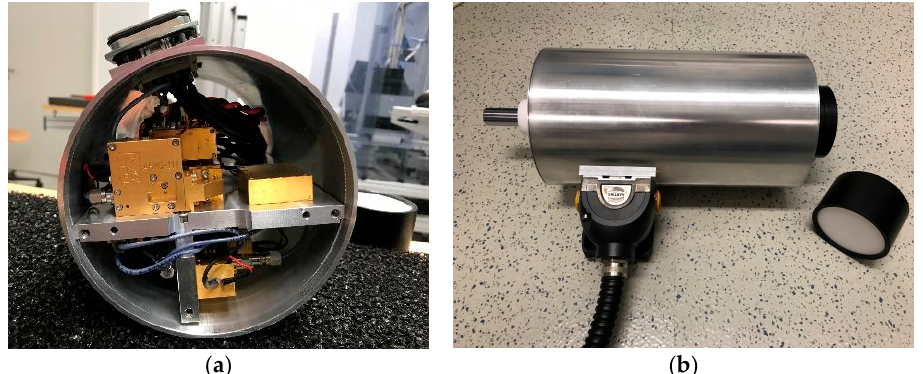
Figure 4. ( a ) Photograph of the two-frequency sensor head mounted inside a cylindrical metallic housing. ( b ) Photograph of the assembled measurement device with data I/O and power supply connector. The focusing lens tube can be exchanged depending on the exact measurement geometry and distance of the object under test.